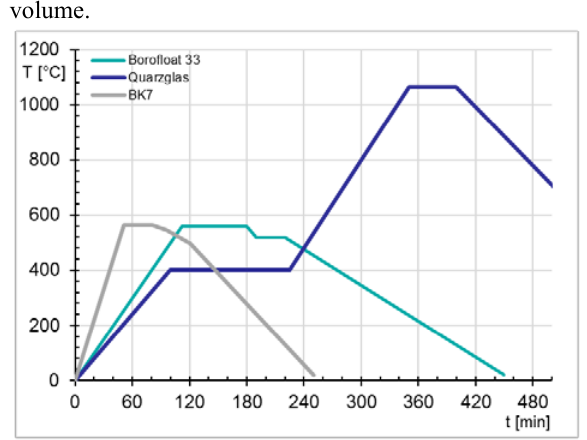
Fig. 1. Temperature-time curves for different glasses.